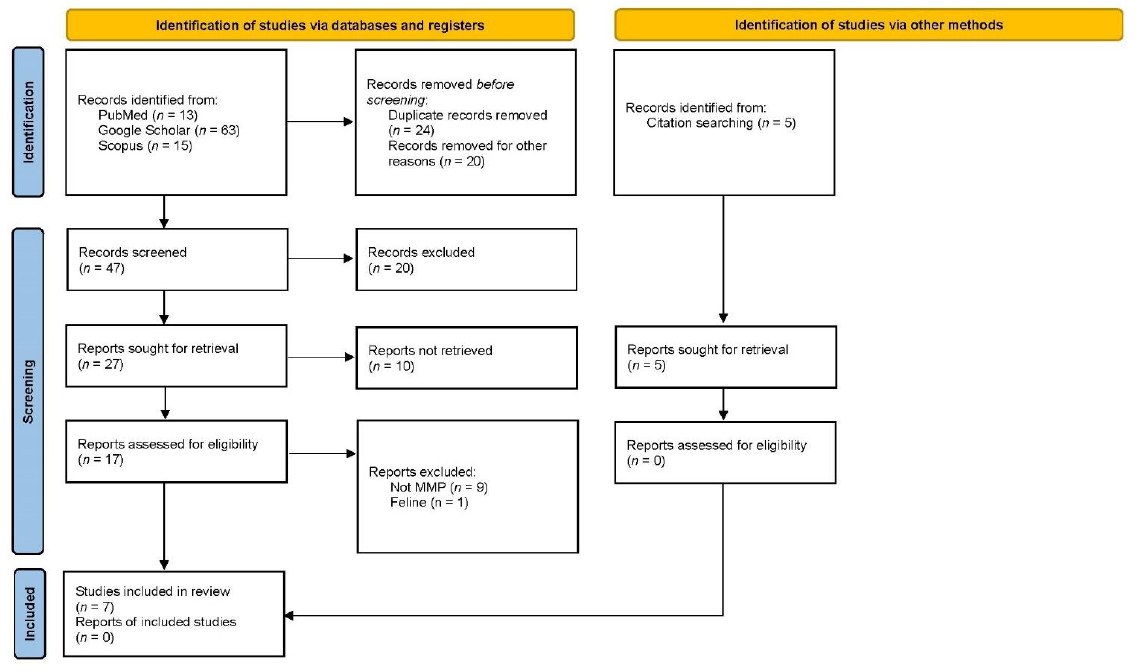
Figure 2. PRISMA 2020 flow diagram for new systematic reviews included searches of databases, registers, and other sources.